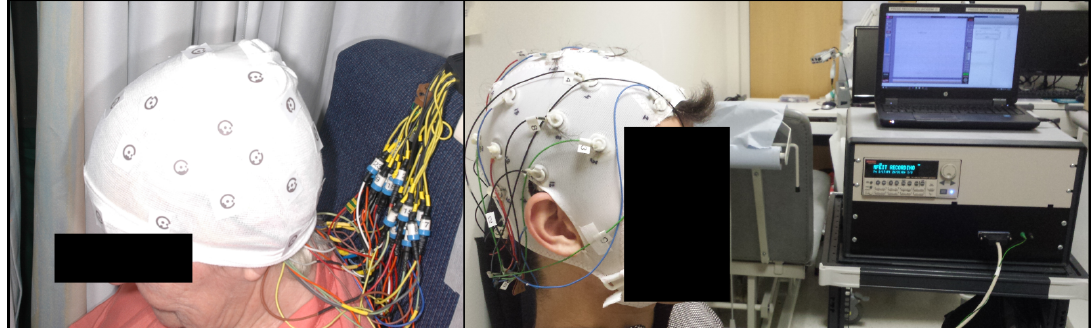
Figure 1. EIT data collection of acute stroke